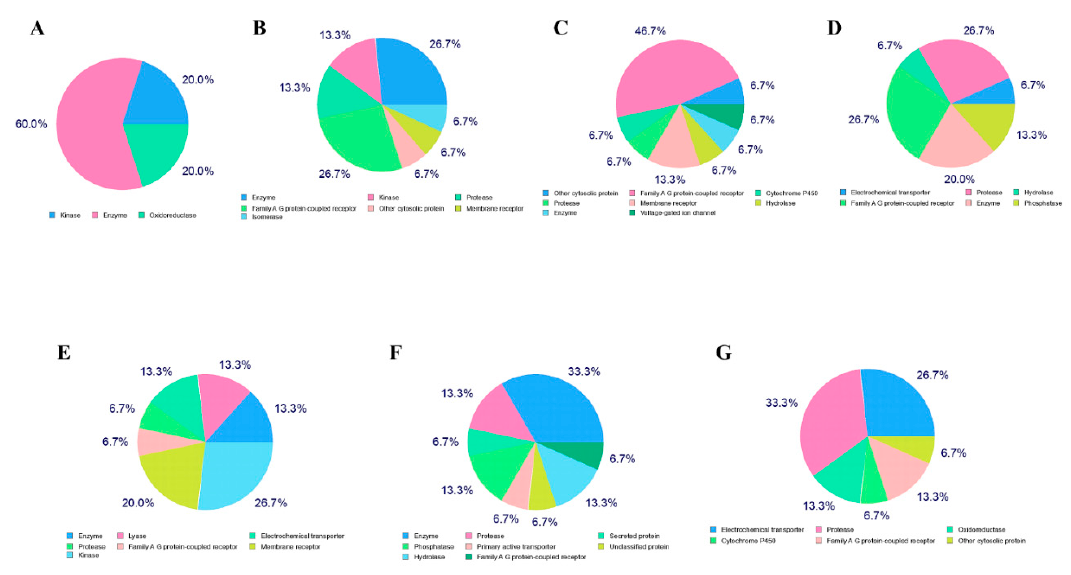
Figure 4. Target prediction, ( A ) remdesivir, ( B ) X77, ( C ) N3, ( D ) camostat mesylate, ( E ) mangiferin, ( F ) glucogallin, and ( G ) phlorizin.